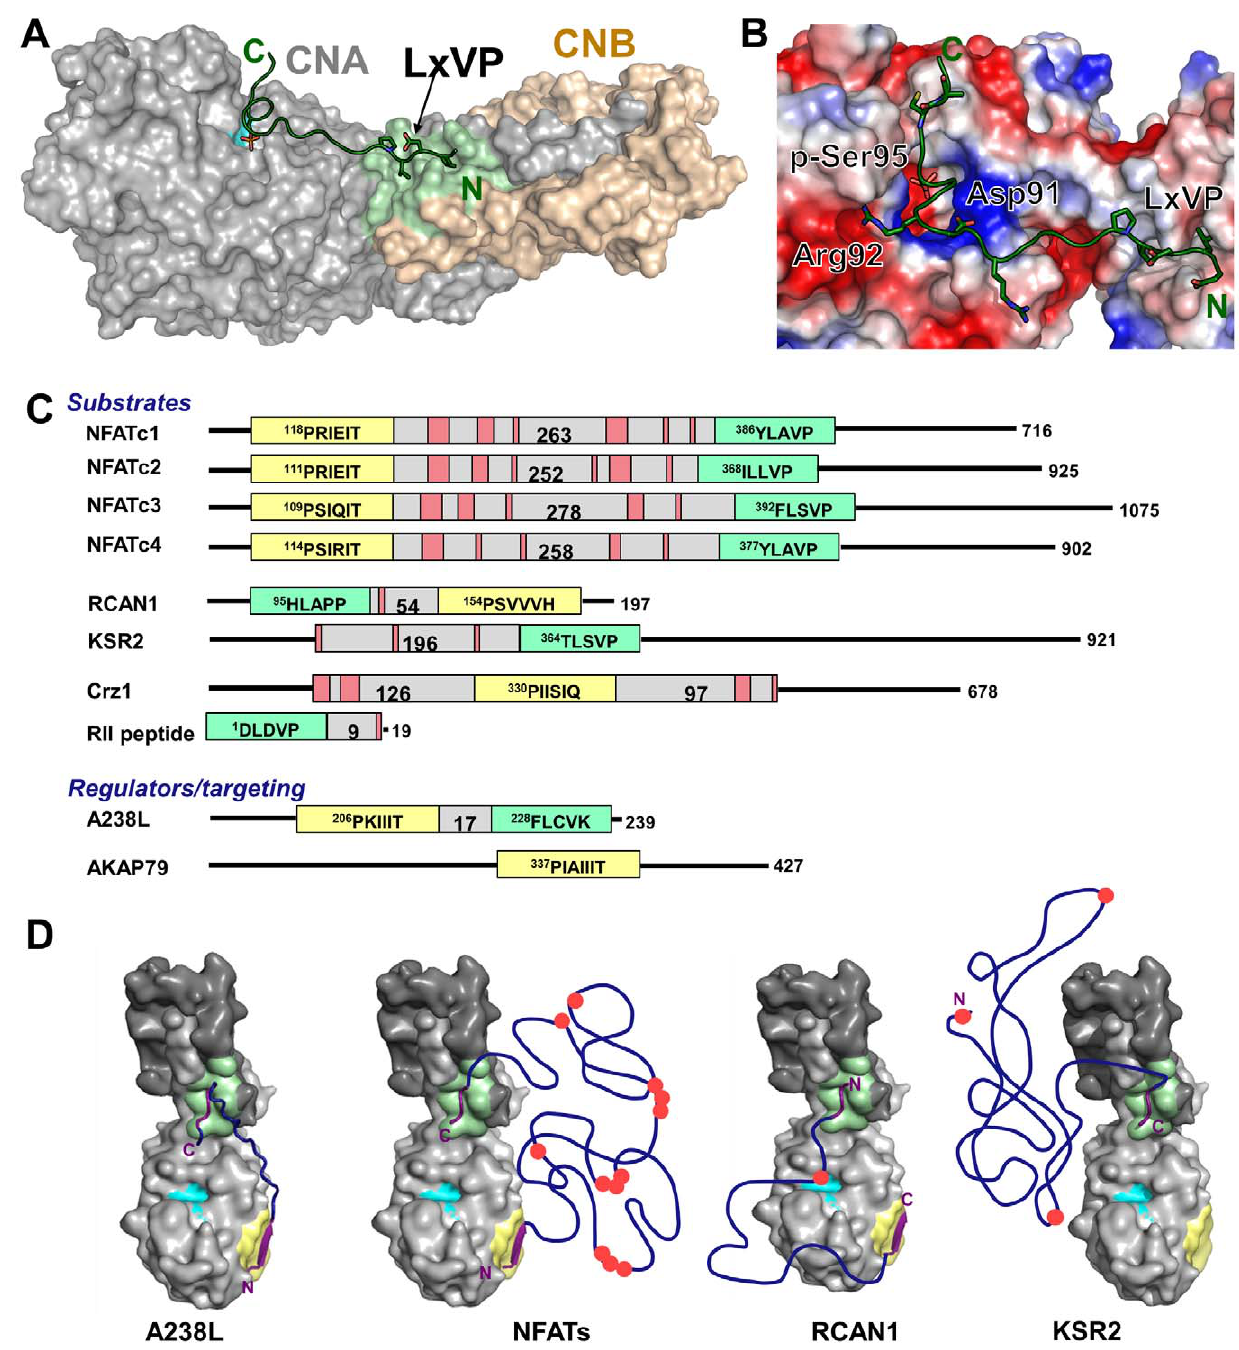
Figure 6. Potential interaction modes of CN substrates/regulators with CN. (A) The CN-RII peptide complex obtained by MD. Colors as in Figure 2A, C. CN is shown in surface representation and the RII peptide in dark green with the LxVP motif (LDVP) and phospho-Ser95 as green sticks. LDVP is bound to the LxVP binding pocket (light green), and phospho-Ser95 is bound in the CN active site (cyan). (B) Electrostatic interactions between CN and the RII peptide. The CN electrostatic surface has positively and negatively charged areas colored blue and red, respectively. The LxVP motif and residues in RII that participate in polar interactions with CN are shown as green sticks. (C) Features of selected CN substrates and regulators, including substrates tested in this work (NFAT, Crz1, and the RII peptide). PxIxIT and LxVP motifs are highlighted in yellow and green, respectively, with intervening residues in grey. Regions containing S-T residues that are dephosphorylated by CN are pink. (D) Potential modes of interaction of CN with various binding partners. CN is shown in grey, with the active site in cyan, the PxIxIT docking site in yellow, and the LxVP docking site in green. CN binding partners are shown in blue, with PxIxIT and LxVP motifs in purple and phosphorylated regions shown as red circles. The residues between the two CN docking motifs, or between one docking motif and regions dephosphorylated by CN, are represented as coils, as they are predicted to be unstructured in solution. A238L is the CN-A238L crystal structure.